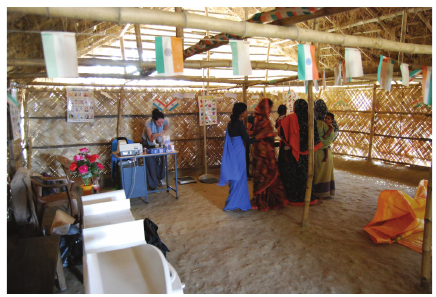
Figure 4: Screening of women of childbearing